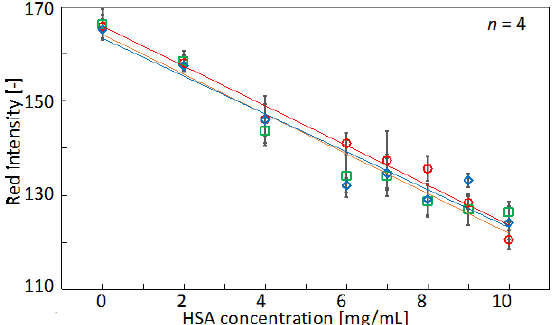
Figure 7. Calibration curves for HSA obtained with variable sample volumes: 0.7 µL (red circles), 0.8 µL (green squares), and 0.9 µL (blue diamonds). Data plots and error bars represent mean red intensities and corresponding standard deviations extracted from four detection zones (parameters of regression lines shown in Table 4).